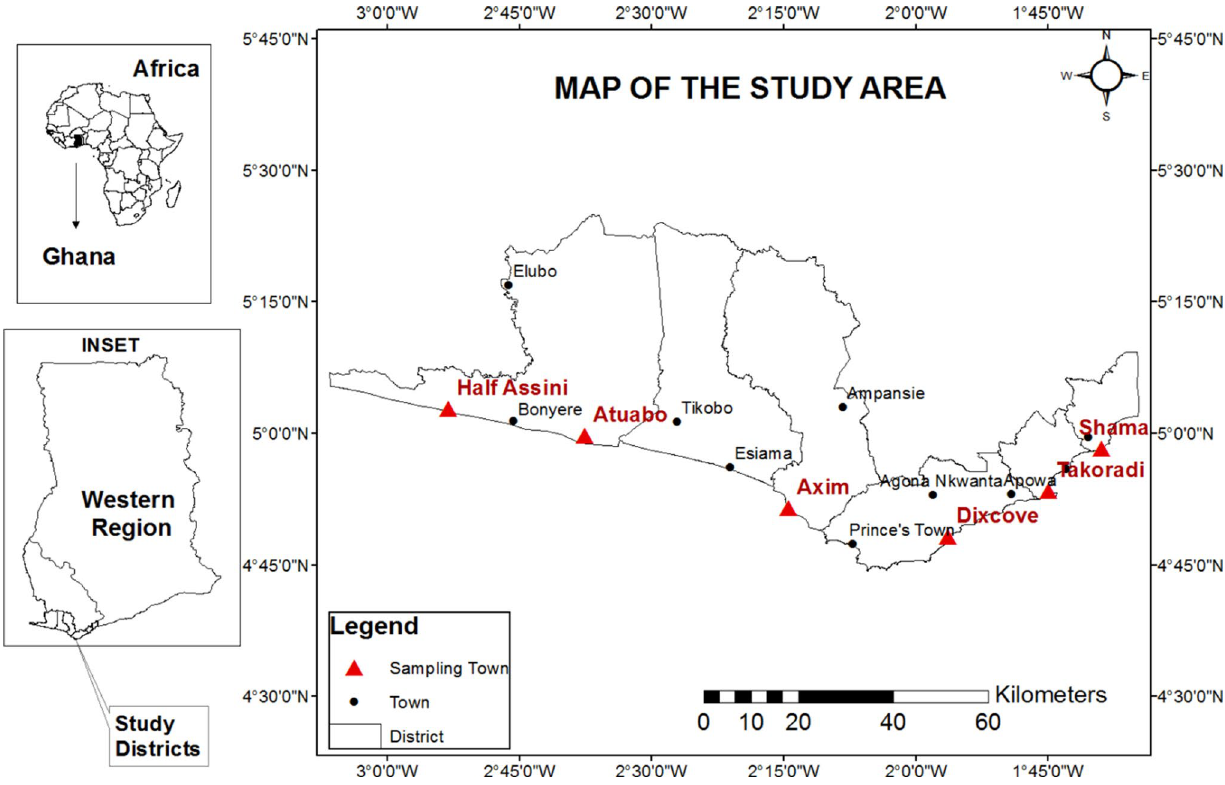
Fig. 1 Map of the study